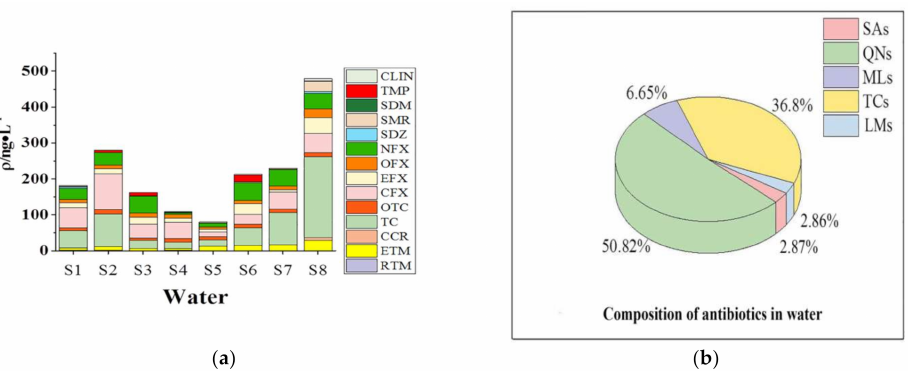
Figure 2. ( a ): Distribution of antibiotics in surface water in Anqing; ( b ): composition of antibitics in water